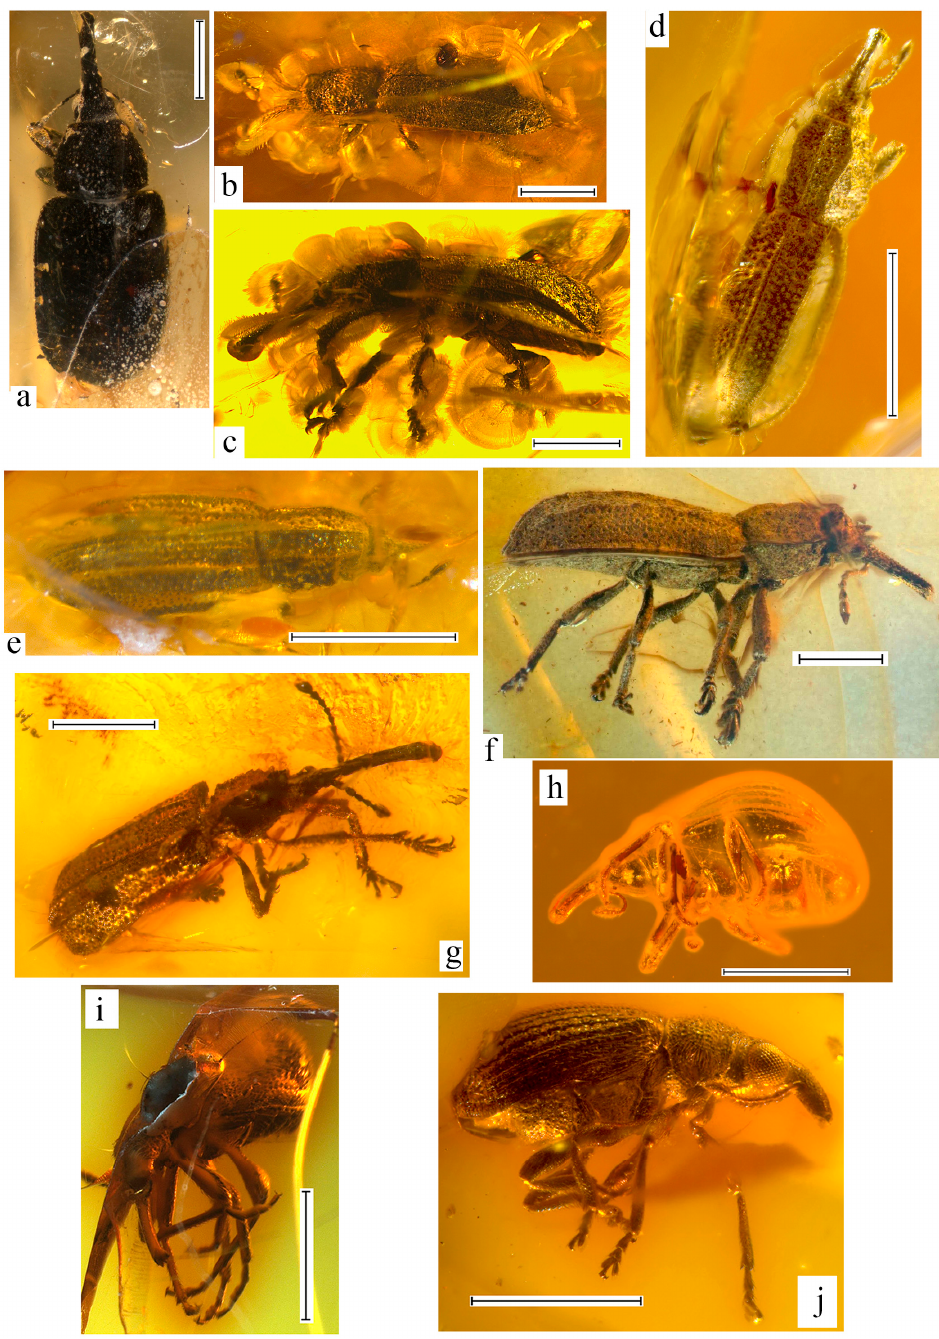
Figure 3. Habitus of Belidae and Rhynchitidae from Baltic amber. ( a ) Oxycraspedus poinari , holotype, ISEA , no. BA2011 / 1, body, dorsally. ( b , c ) Archimetrioxena electrica , holotype, GPIH , no. 194: body, dorso-laterally ( b ); body, laterally ( c ). ( d ) A. electrica , specimen, ISEA , no. 2012 / 18, body, dorsally. ( e ) A. zherikhini , holotype, PIN . no. 964 / 1236, body, dorsally. ( f ) Succinometrioxena poinari , holotype, ISEA , no. BA2015 / 2, body, laterally. ( g ) S. bachofeni , holotype, ISEA , no. BA2012 / 6, body, dorsally. ( h ) Baltoconapium anderseni , holotype, ZMUC , no. 959, body, ventrally. ( i ) Baltocar succinicus , holotype, GPIH , no. 195, body, laterally, in front. ( j ) Palaeotanaos oisensis , specimen, MNHN , no. PA533, body, laterally. Scale bars: 1.0 mm. See Section 2 for names of collections.